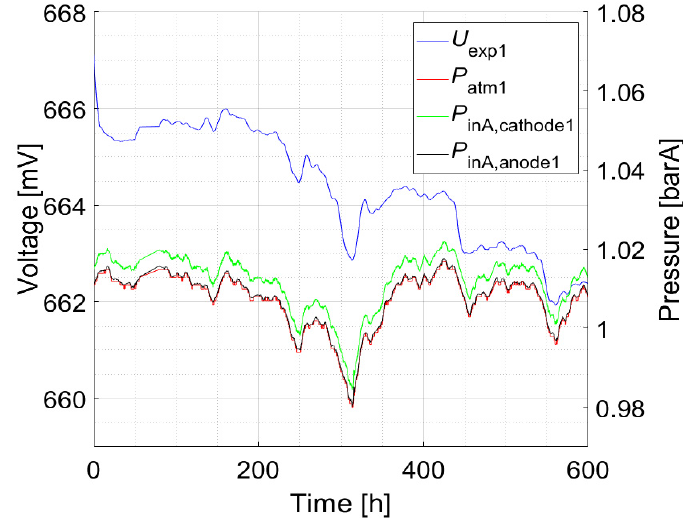
Figure 1. Temporal evolution of the voltage ( U exp1 ), H 2 ( P inA,anode1 ) and air ( P inA,cathode1 ) inlet pressures and atmospheric pressure ( P atm1 ) during a 600 h endurance test with an Advent PBI MEA (45.2 cm²) operated at 160 °C, 0.2 A/cm², without back-pressure regulation and with stoichiometries of 1.2/2 for H 2 /air.